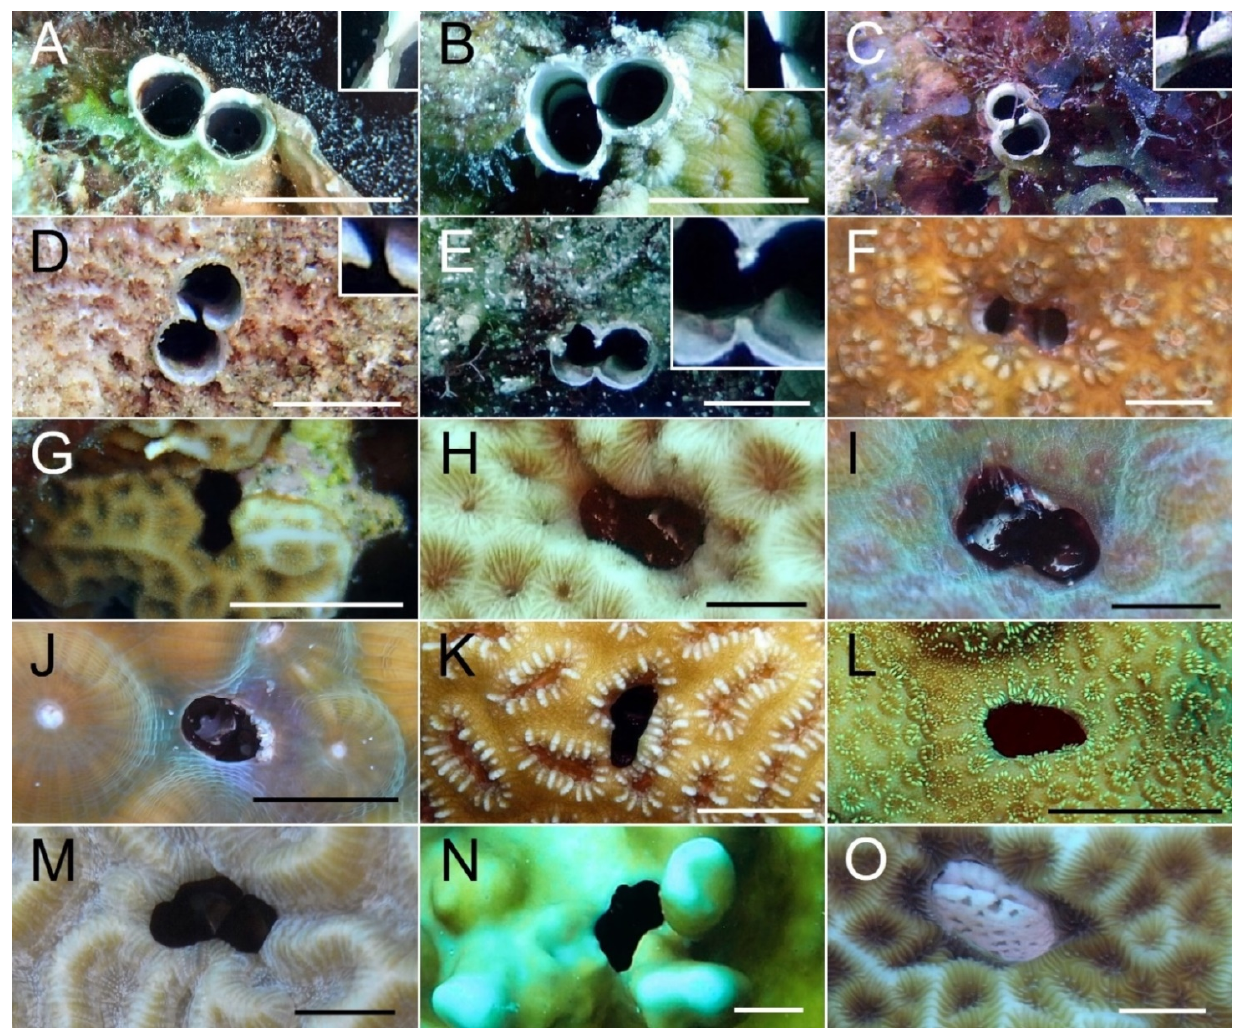
Figure 2. Morphological variation of orifices in corals containing Leiosolenus mussels at Curaçao. ( A – E ) Figure-of-eight shape with two calcareous tubes showing black siphon tissue inside; the tubes are connected apart from a slit (inserts: 2.5× enlargement). ( F ) The siphon tubes are separated by the host coral. Black mantle tissue is cloaking holes that are shaped like a dumbbell or keyhole ( G – I ), an oval ( J – L ), or an irregular ink blotch ( M , N ). ( O ) A hole containing valves of a dead mussel. Substrate: dead coral ( A , C , D ); live corals of Orbicella franksi ( B , I ), Montastraea cavernosa ( E , J ), Madracis senaria ( F ), Agaricia humilis ( G , O ), Siderastrea siderea ( H ), Favia fragum ( K ), Porites astreoides ( L ), Pseudodiploria strigosa ( M ), Millepora alcicornis ( N ). Scale bars: 1 cm.